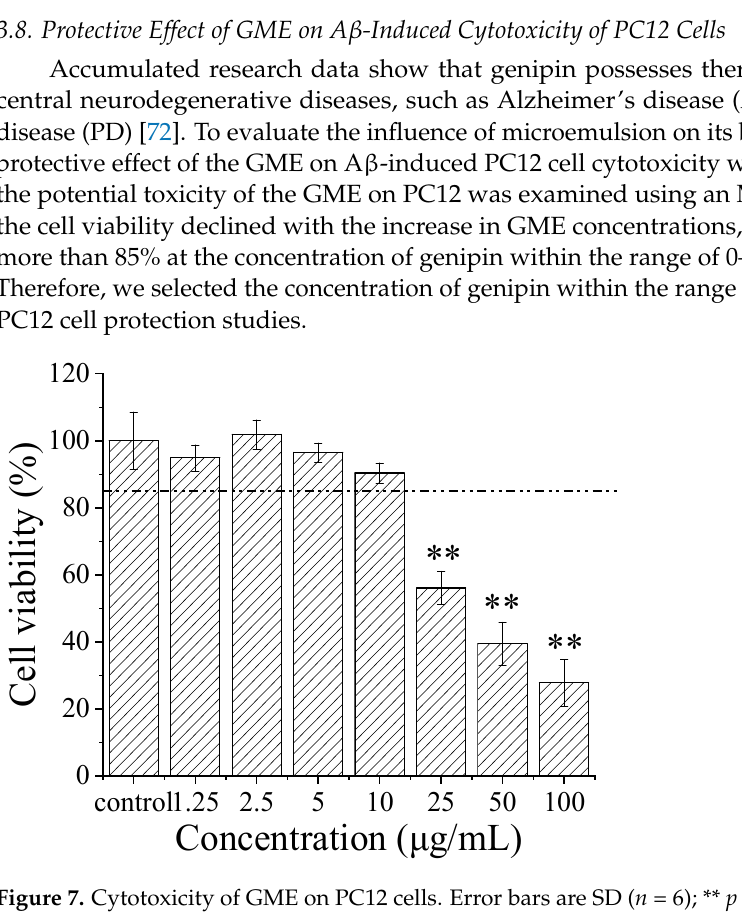
Figure 6. Cellular uptake of GME quantified with CLSM and HPLC. Confocal microscopy images of Caco-2 cells. Scale bar = 20 µ m ( A ); HPLC quantification of genipin uptake by Caco-2 cells treated by free genipin and GME at 37 ◦ C for 0.5, 1, 2, and 4 h ( B ). Different letters (a,b) indicate a significant difference at different time in the Genipin group; different letters (A,B,C) indicate a significant difference at different time in the GME group. * p < 0.05, ** p ≤ 0.01. Compared with the group treated with the same concentration of free genipin.